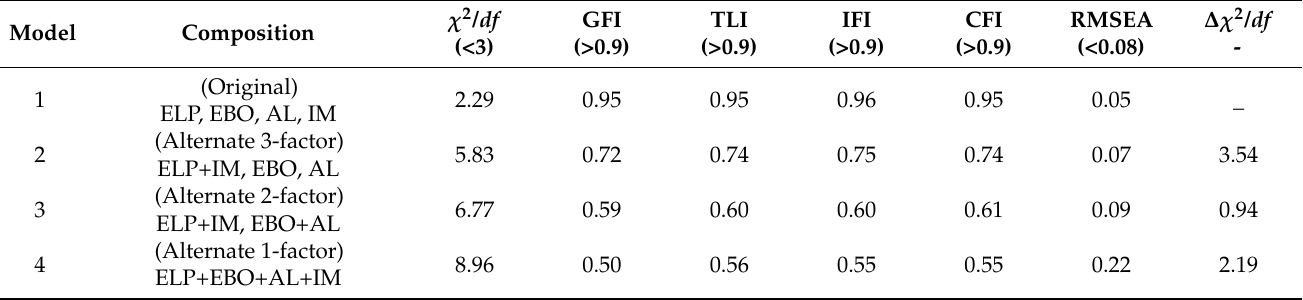
Table 4. Model fit comparison, alternate vs. hypothesized models.